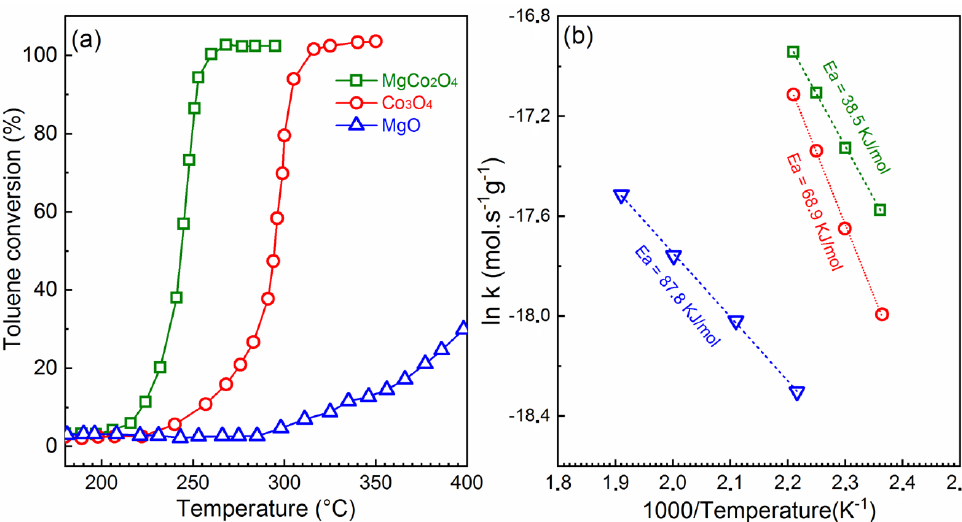
Figure 7. ( a ) Light-off curves and ( b ) Arrhenius plots of toluene reaction rates over spinel (MgCo 2 O 4 , Co 3 O 4 ) and MgO catalysts. Co 3 O 4 ) and MgO